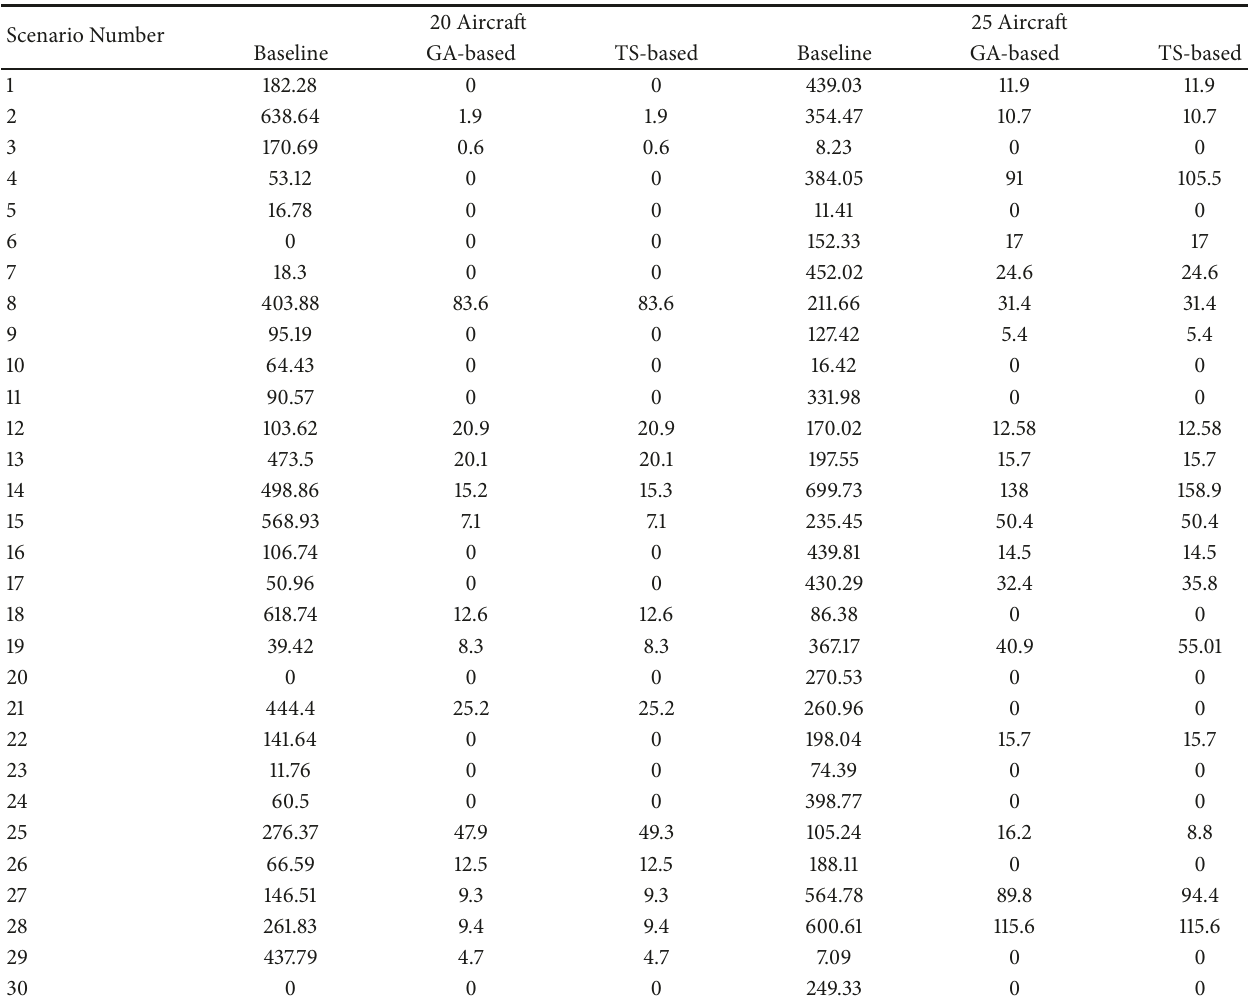
Table 10: The delayed aircraft vector deflection model fuel consumption